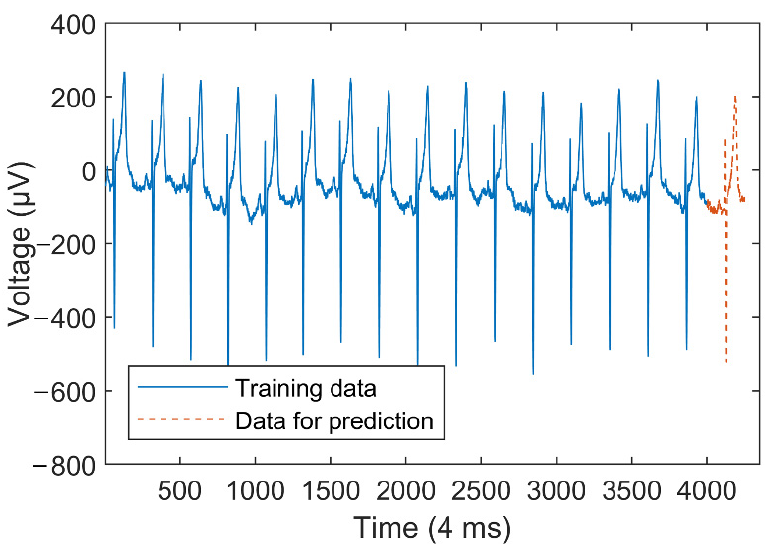
Figure 12. Electricity consumption forecast results of Tetuan city. The American Heart Association (AHA) ECG datasets collect voltage values at a sam- pling rate of 250 Hz. A complete ECG waveform contains about 250 sampling points. So, when constructing various FIGs, the length of the time window is set as 25, which is about one-tenth of a whole waveform. Figure 13 plots a time series containing 4250 sampling points. The first 4000 sampling points (including about 16 waveforms) are used as the training set to predict the last 250 sampling points (about 1 waveform).